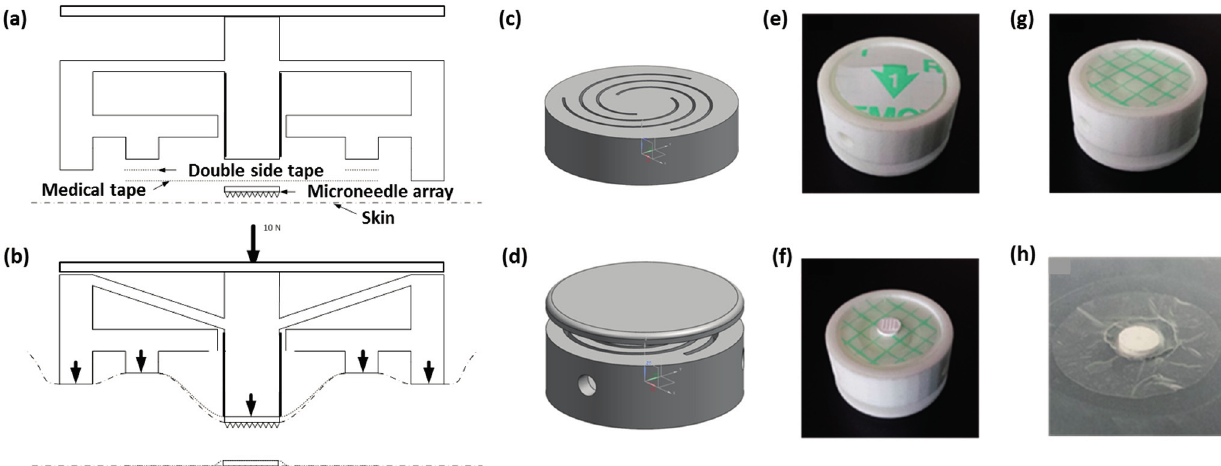
Figure 7. Design, realization and use of the 3D-printed spiral-spring applicator. ( a ) Schematic drawing of the applicator in the resting state; ( b ) Schematic drawing of the applicator in the pushed-in state; ( c ) 3D-design impression of the applicator without the push-plate; ( d ) 3D- design impression of the applicator with the push-plate; ( e ) Bottom view of the applicator assembled with an adhesive on the inner ring; ( f ) The same applicator as in ( e ) after removal of the protective foil of the adhesive and an npMNA attached atop; ( g ) Applicator with remainder of the back-side protective foil of the adhesive after insertion; ( h ) npMNA held in position by the adhesive atop a skin